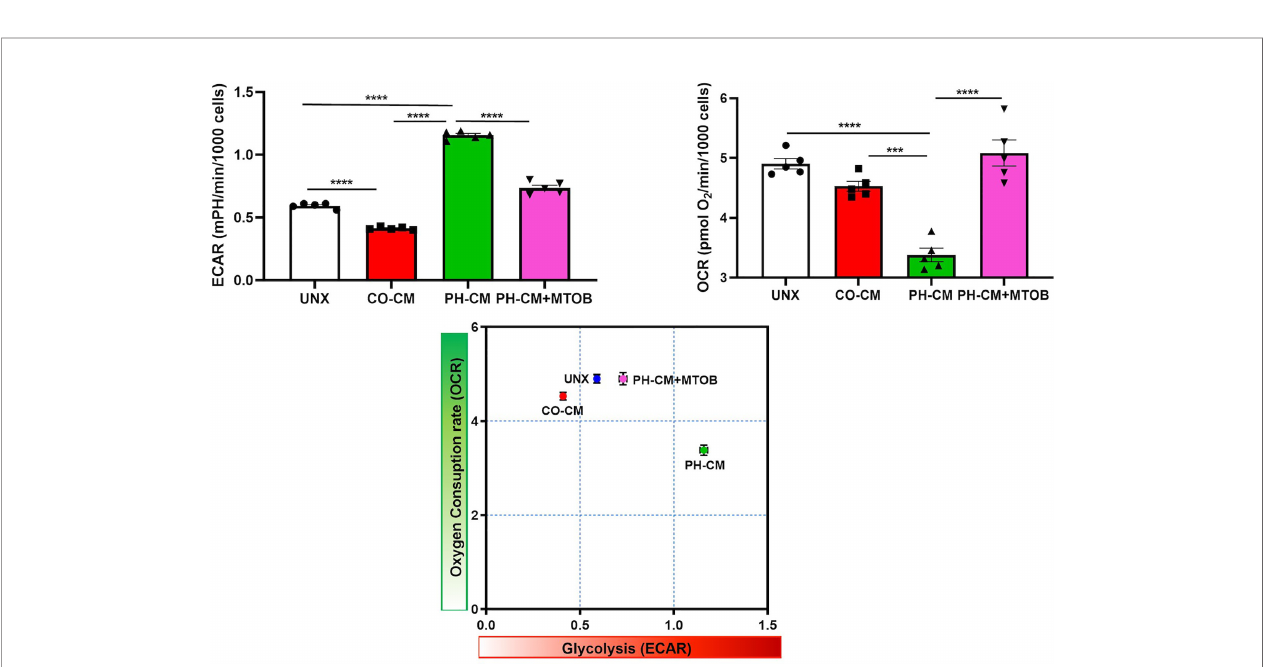
FIGURE 8 | Inhibiting CtBP1 by MTOB reversed the effects of PH-CM on macrophage glycolysis (ECAR) and oxygen consumption (OCAR). CM was collected from CO-Fibs, PH-Fibs or PH-Fibs treated with MTOB. BMDM was exposed to CM for 18hrs prior to their analysis for extracellular acidi fi cation rate (ECAR) and oxygen consumption rate (OCR) with Seahorse XF96 analyzer to determine the effects of CtBP1 inhibitor, MTOB, on macrophage glycolysis and mitochondrial OXPHOS. *** p < 0.001, **** p <